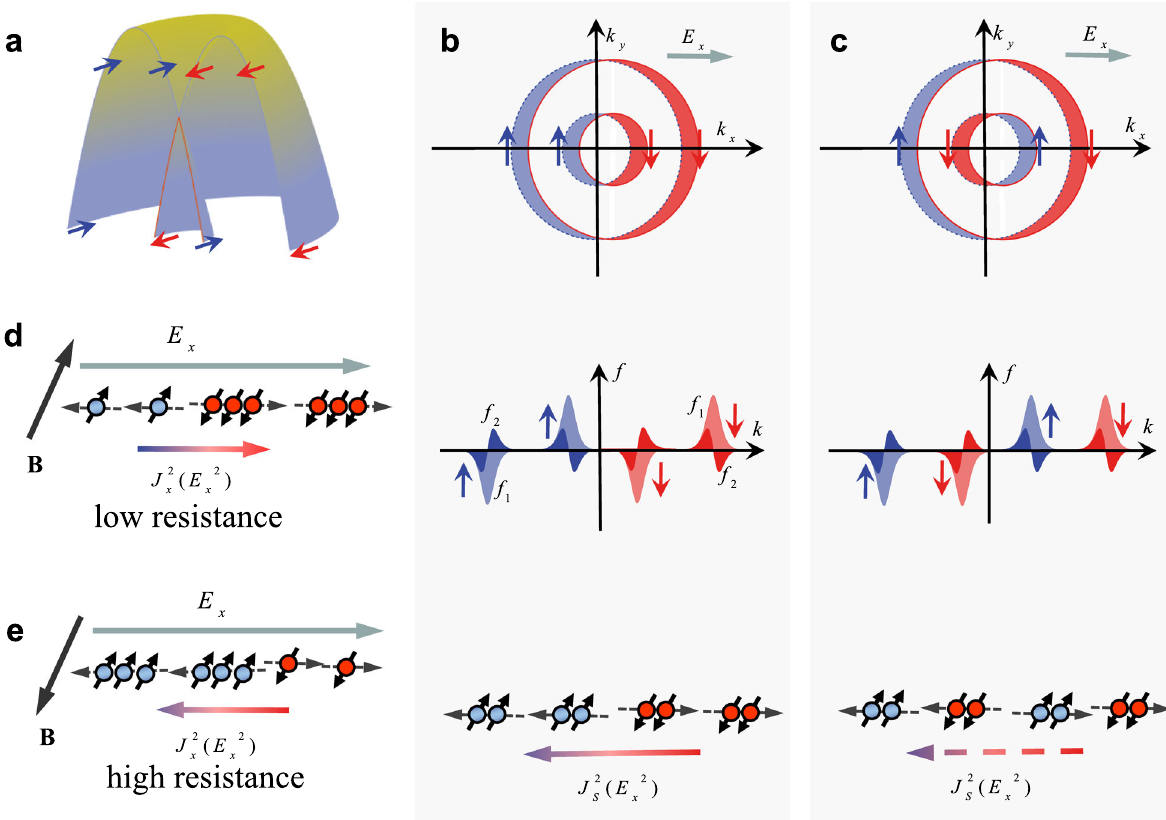
Fig. 3 The physical fi gure of UMR in 2D nonmagnetic Rashba systems. a Sketch of 2D Rashba-type band structures at equilibrium. b Top: schematics of Fermi contours (dash circles) above BCP. The outer and inner contours hold the identical spin helicities. The red and purple arrows represent the spin-up and spin-down states, respectively. An applied electric fi eld E x along k x axis induces a shift of the Fermi contours (solid circles) toward k x axis, resulting in an imbalance of carrier occupation on two sides of the Fermi contours. Middle: illustrations of fi rst-order f 1 ( fi lled in light red or light purple color codes) and second-order f 2 ( fi lled in dark red or dark purple color codes) corrections to the equilibrium distribution function f 0 in E x . The parts of f 1 and f 2 above k axis depict excess of carrier along the arrow direction, whereas other parts below k axis denote depletion of the same. Bottom: the second-order spin current J 2 ð E 2 Þ induced by E x . c Top: schematics of Fermi contours with E x (solid circles) and without E x (dash circles) below BCP. The outer and inner contours x S depict the opposite spin helicities. The corresponding f 1 and f 2 is illustrated in middle panel. In this case, J 2 ð E 2 Þ is partially converted into a nonlinear charge current J 2 helicities (bottom panel). d , e J 2 x S (antiparallel) to the spin polarization direction corresponds to a low (high) resistance